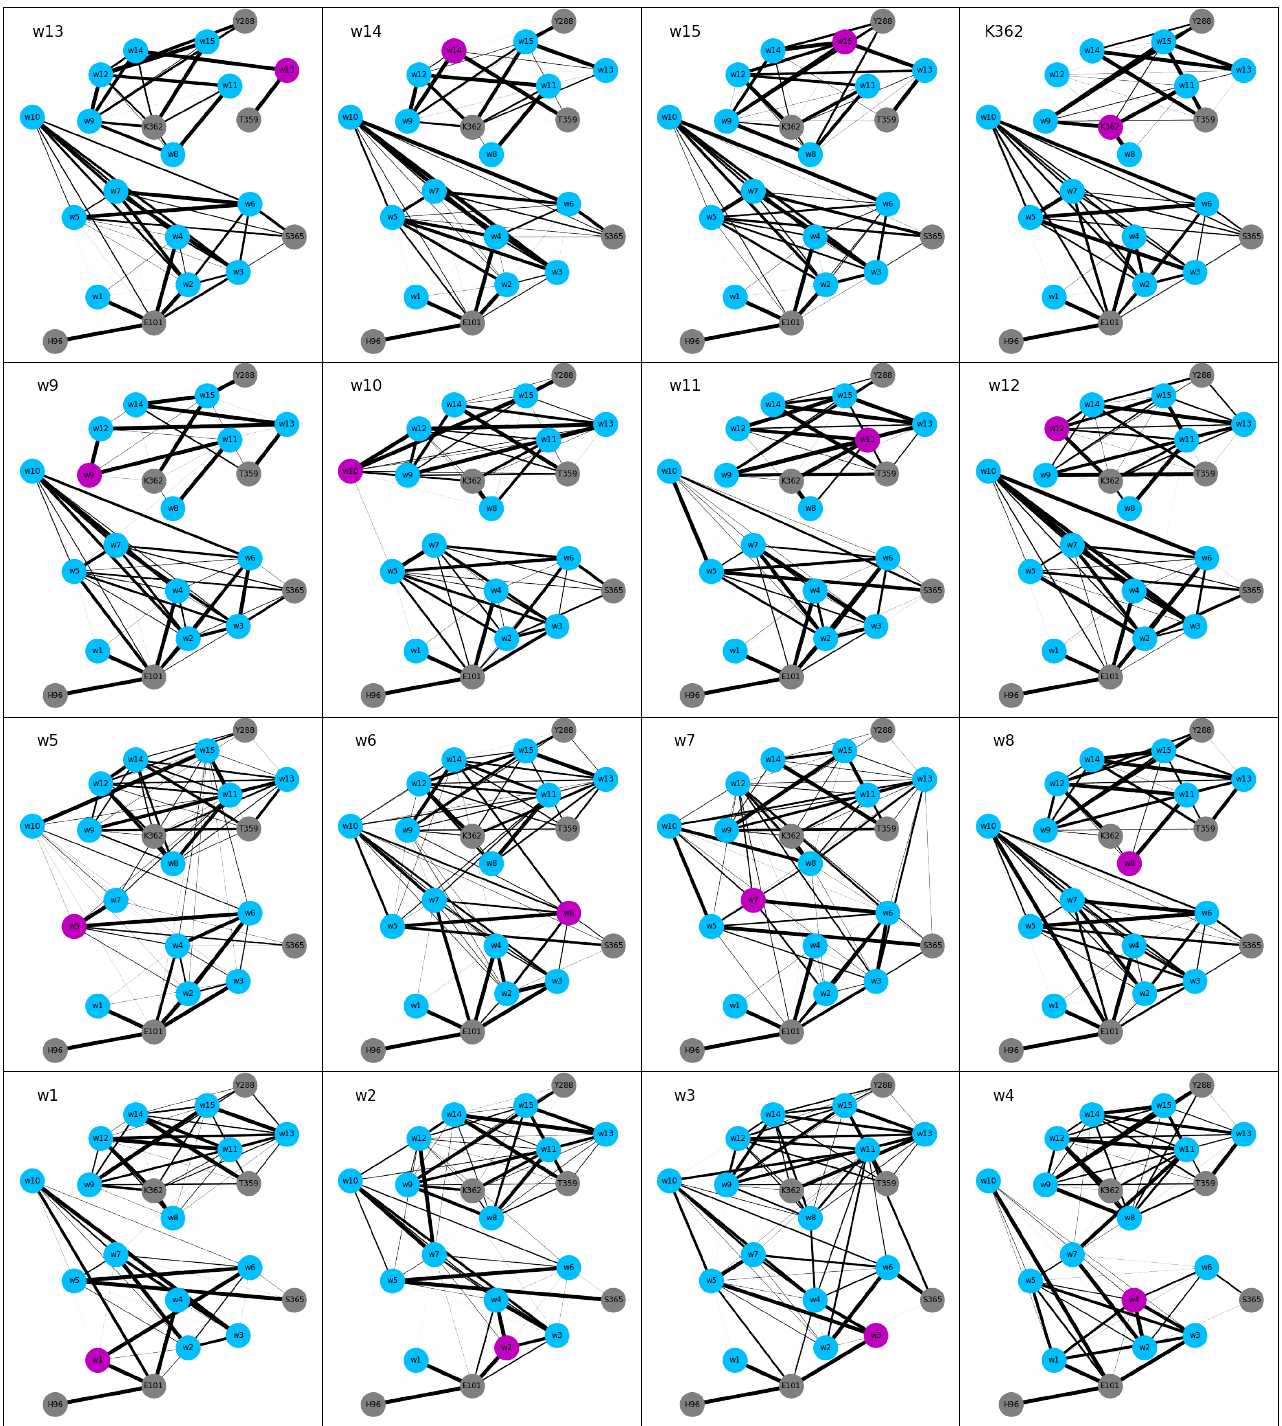
Figure 4. Undirected hydrogen bonded network computed from the MD simulations with the excess proton located at different residues, based on a snapshot with K362 in “up” position. The nodes of the network are the protein residues (in gray) Y288, T359, K362, S365, H96, or E101, and the fifteen water molecules (in blue) in the channel. The residue carrying the excess proton is highlighted in magenta. Edges of the network correspond to hydrogen bonds and are shown as lines. The thickness of the lines indicate the probability of the hydrogen bonds. Hydrogen-bonded networks of models with protonated H96 and E101, respectively, are shown in Supplementary Figure